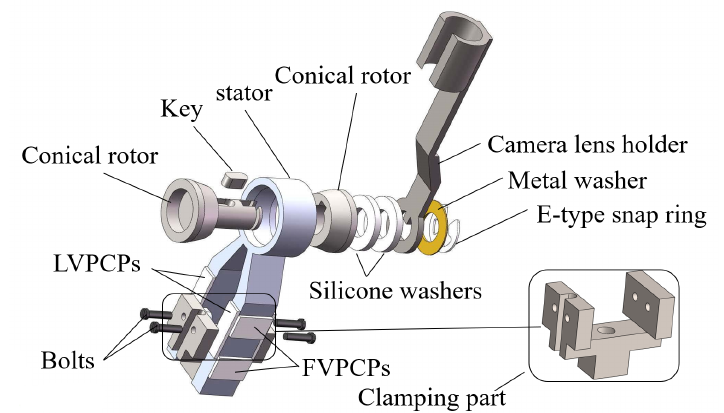
Figure 6. Structural scheme of the miniature traveling wave tilt ultrasonic motor.